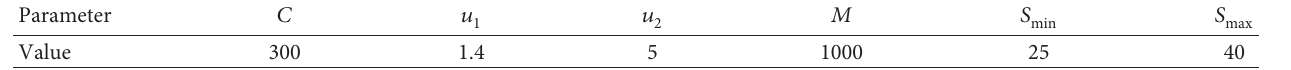
Table 3: Parameter values of the optimized model of the parking spot